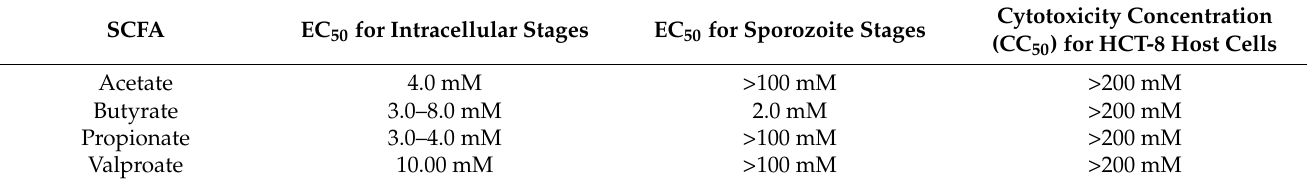
Table 1. Effects of short-chain fatty acids on infected HCT-8 cells. EC 50 and CC 50 of HCT-8 cells infected and treated with different SCFAs.